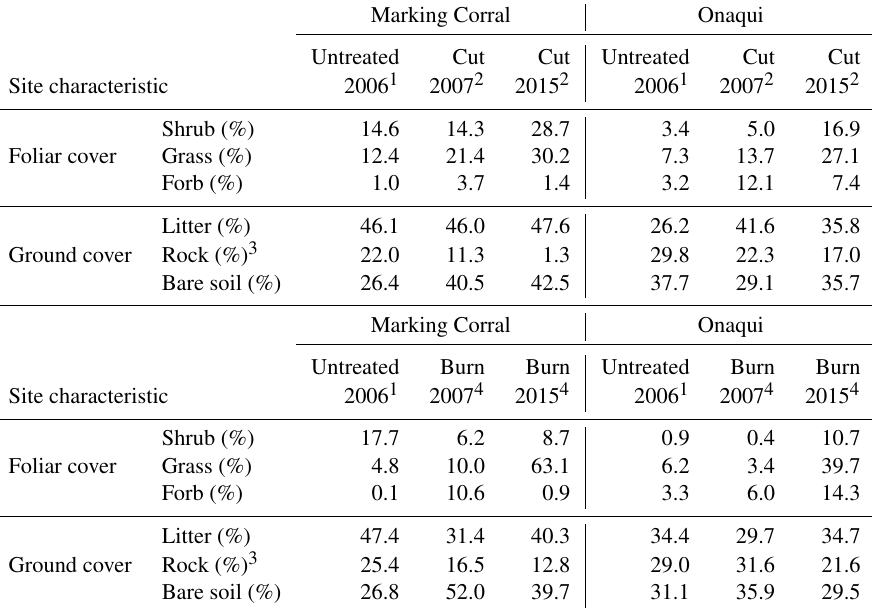
Table 3. Select foliar cover and ground cover measures on hillslope-scale site characterization plots (990m 2 ) in cut and burned treatment areas at the Marking Corral and Onaqui sites 1 year prior to tree removal (2006) and 1 year (2007) and 9 years (2015) after tree-removal